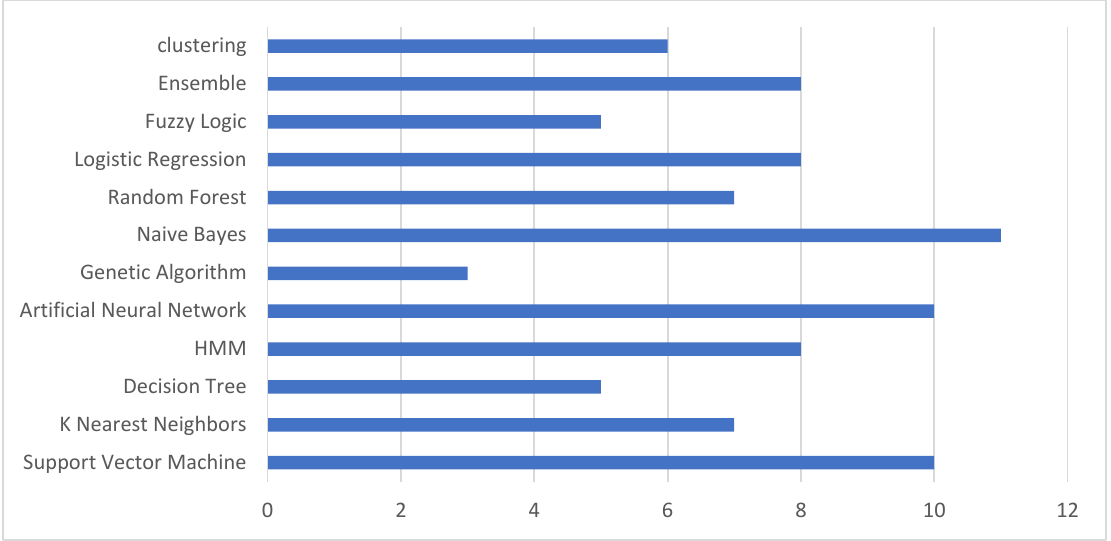
Figure 4. Frequency of the machine learning methods used for fraud detection.